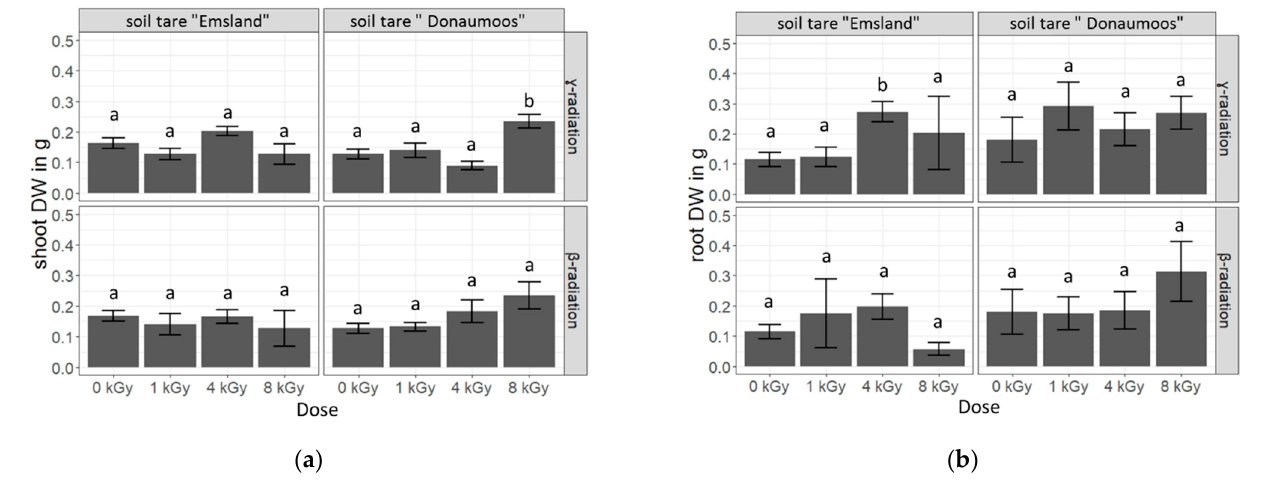
Figure 5. ( a ) Shoot and ( b ) root dry mass of four-week-old Zea mays seedlings growing in γ irradiated (upper panels) and β irradiated (lower panels) soil tare “Emsland” (left panels) and soil tare “Donaumoos” (right panels). Bar plots indicate the mean values and standard deviation of four replicates per treatment. Data were analysed by ANOVA Dunnett´s post hoc test. Lowercase letters indicate the significant differences of shoot ( a ) and root ( b ) dry weights compared to their respective controls (0 kGy), ( p ≤ 0.05).